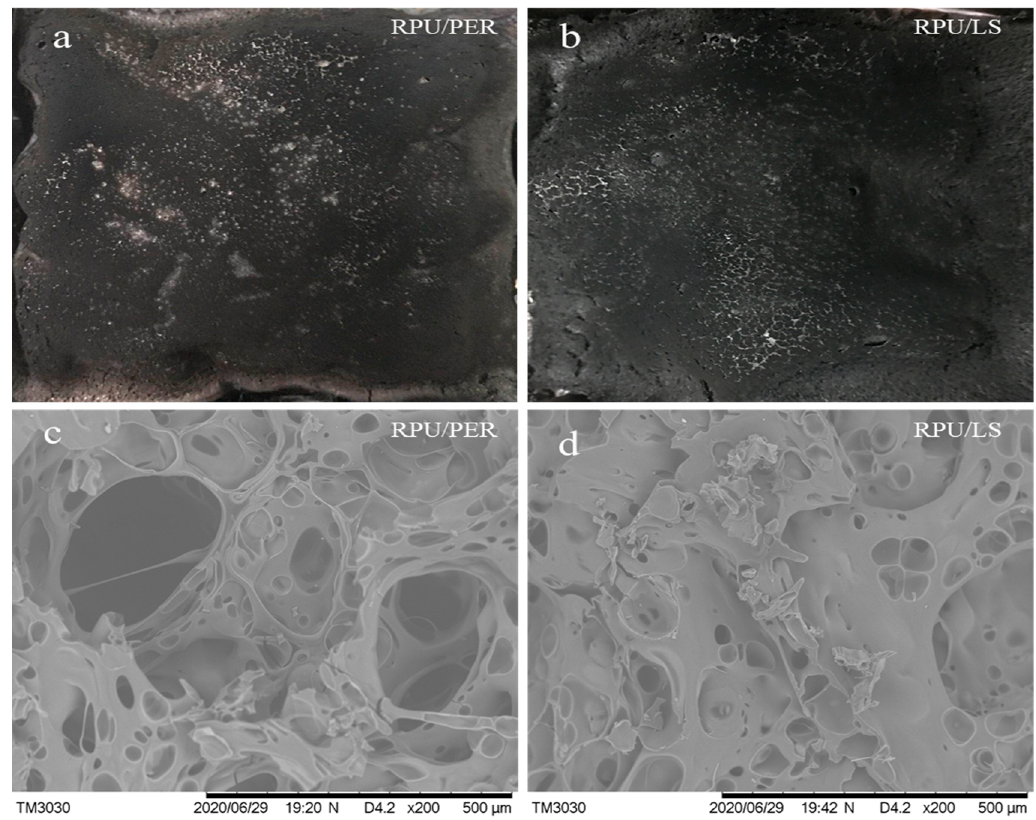
Figure 4. Digital photos ( a , b ) and SEM micrograph ( c , d ) of char residues for RPU/PER and RPU/LS foams.